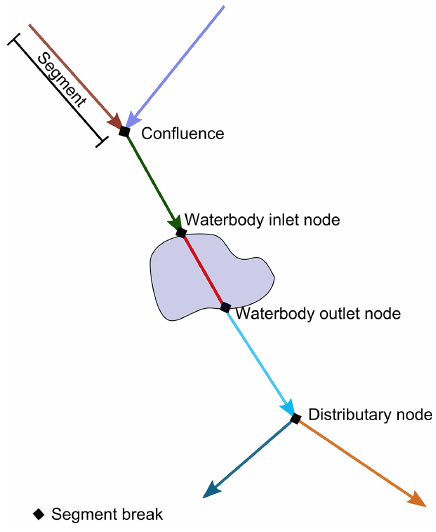
Figure 3. Breaks inserted into the DEM stream network at con- fluences, distributary nodes and water bodies. The breaks delineate uniquely identified stream